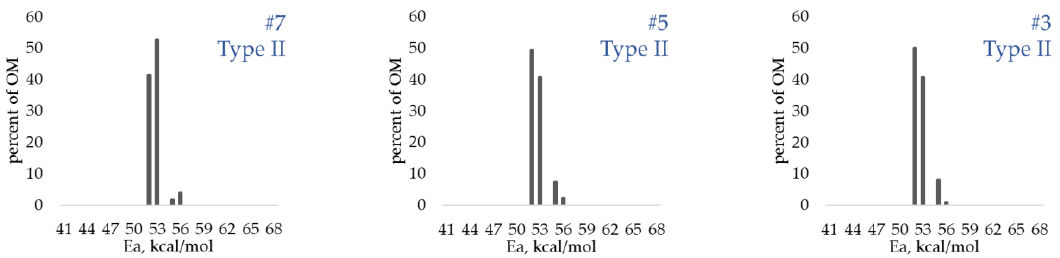
Figure A2. Representative bulk kinetic spectra (A = 1 × 10 14 s − 1 ) of kerogen decomposition for high TOC members #3, #5, and #7.